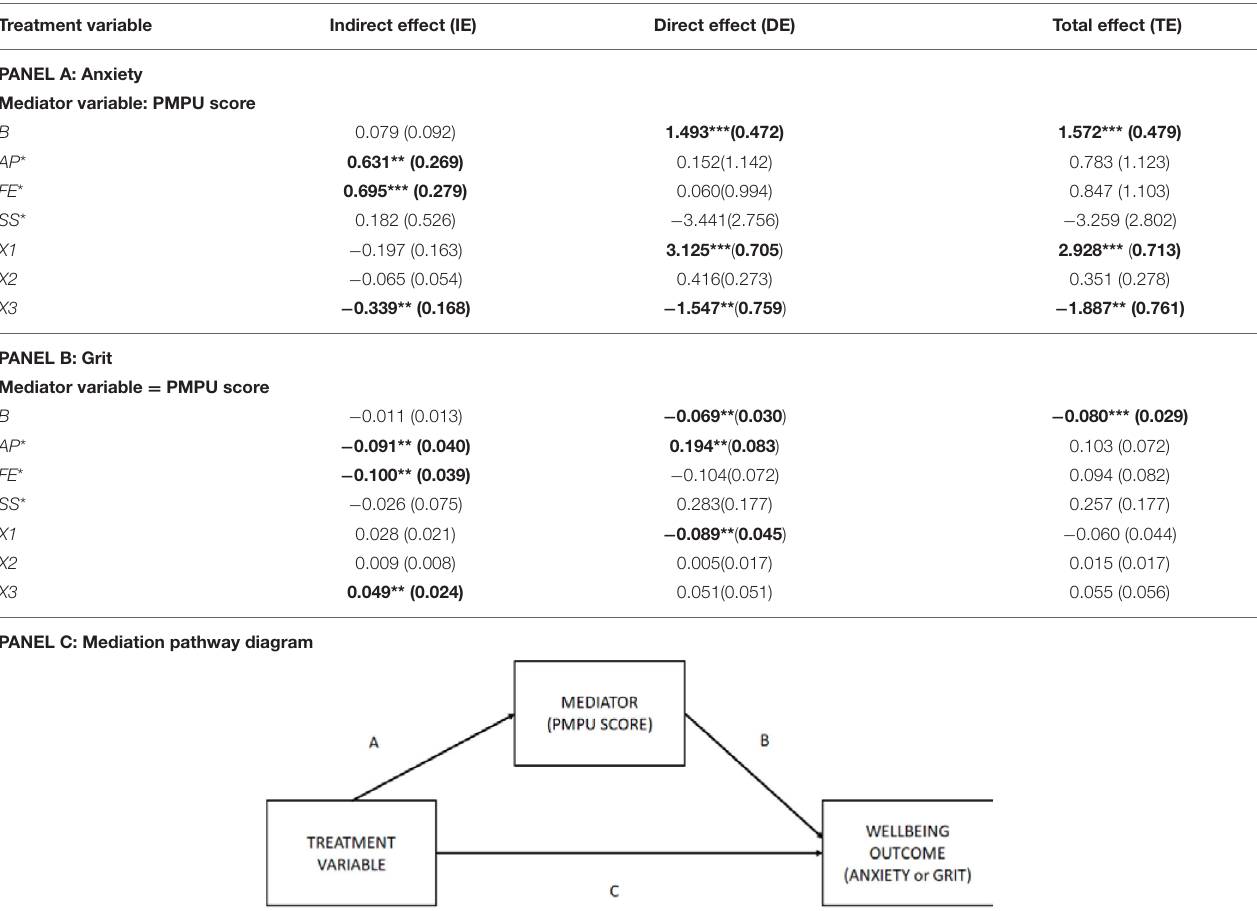
TABLE 4 | Mediation analysis for linear probability estimation of structural model of adolescent life influences on well-being. Treatment